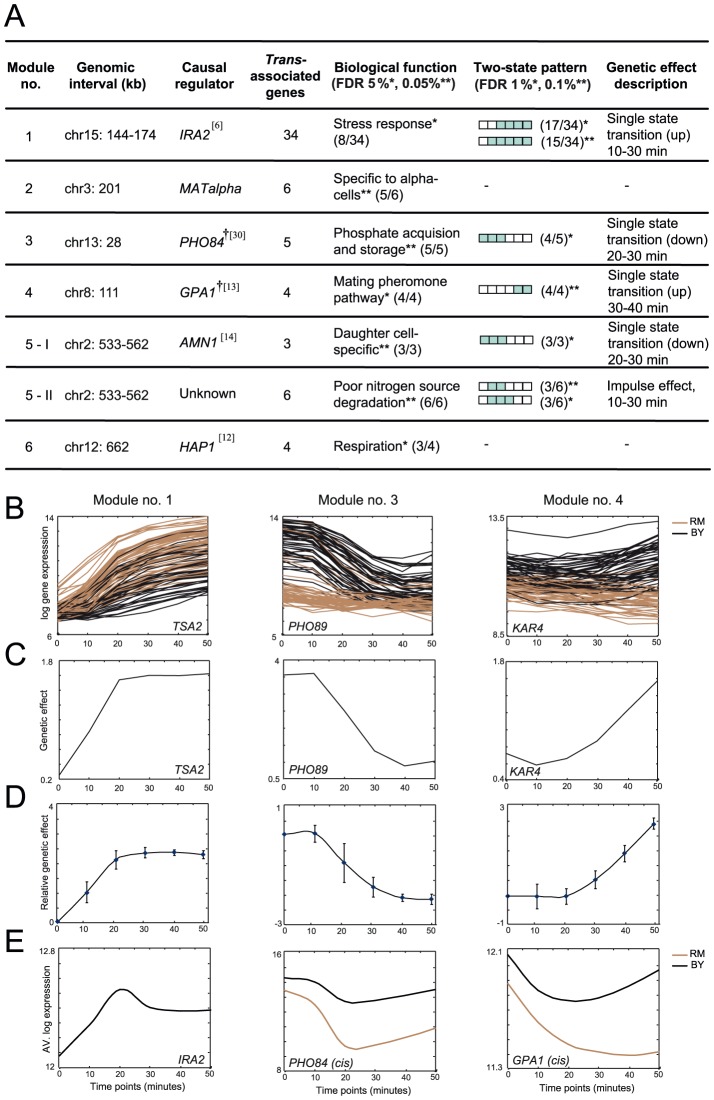
Co-associated genes typically share a similar pattern of genetic effects over time.(A) Six gene modules (column 1), constructed on the basis of a shared trans-associated genetic variant (a genomic interval; column 2), are listed together with their known causal gene, if available (column 3; †
-cis-associated causal gene, references are in parentheses) and the number of associated genes in a module (column 4). Significant enrichments in biological processes are detailed in column 5. Significant enrichments of temporal two-state patterns in each module are presented together with the description of these enriched patterns (columns 6 and 7, respectively). (B−E) Gene expression and genetic effects in modules nos. 1 (left), 3 (middle) and 4 (right). Gene expression (B) and genetic effect (C) of representative genes, as well as genetic effects of an entire module (D); plots are shown as in Fig. 4B. (E) Average gene expression (y-axis) at six time points (x-axis) for the known causal gene of each module. For cis-associated causal genes (modules nos. 3 and 4), brown and black indicate strains carrying the RM and BY alleles, respectively. The plots demonstrate the good match between the timing of abrupt changes in causal genes (E) and the timing of alterations in the observed genetic effects of their associated target genes (D).